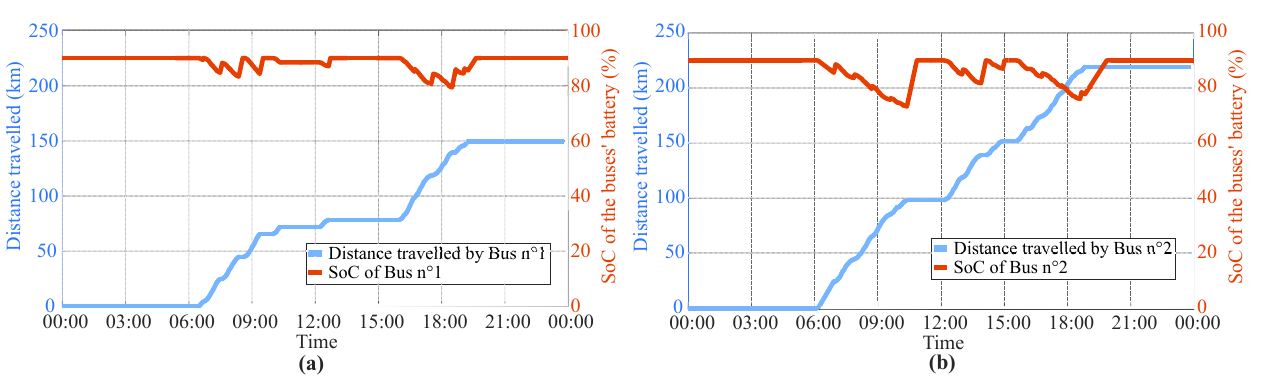
the line terminals. The total energy consumption is 373 kWh, which represents an average consumption per travelled distance of 1.01 kWh/km.